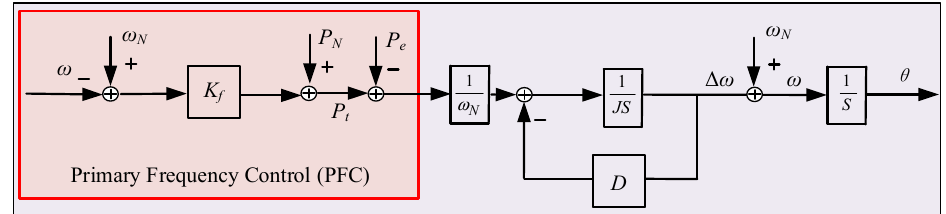
Figure 1. Primary frequency control.